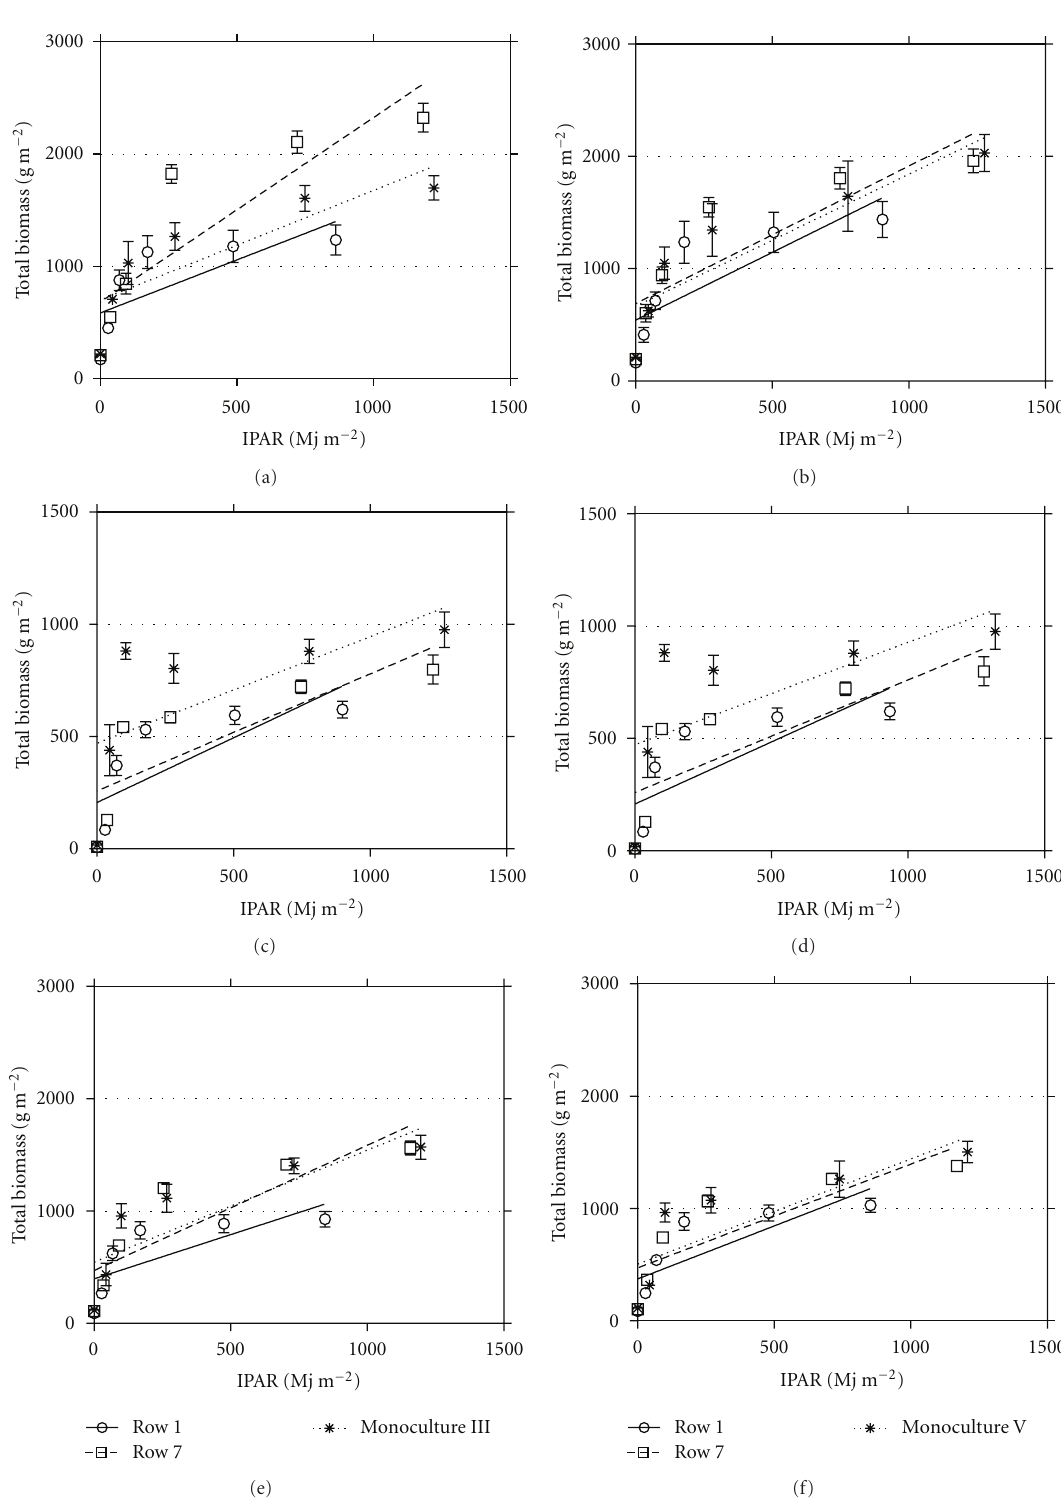
Figure 8: Total biomass versus IPAR in rows 1 and 7 of strips and in the monoculture, during C1 (a) and (b), C2 (c) and (d) and C3 (e) and (f). (a), (c), and (e) correspond to soybeans MG III, and (b), (d), and (f) to corn-soybeans MG